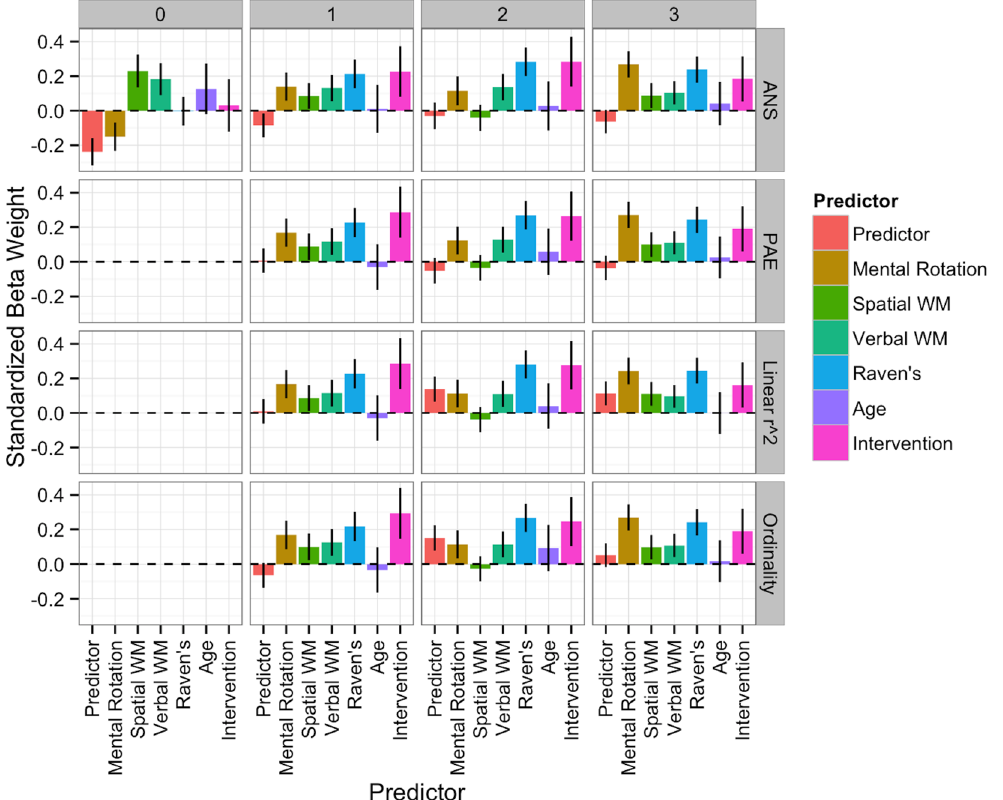
Figure 2. Standardized Beta weights (bars are standard error) when predicting standardized math scores from each of our predictors (ANS, PAE, Linear r 2 , and Ordinality), controlling for other non-numerical tasks. Each cell represents the results of a single model output, such that the results of 13 models are depicted. Columns represent years of test (Y0-Y3).